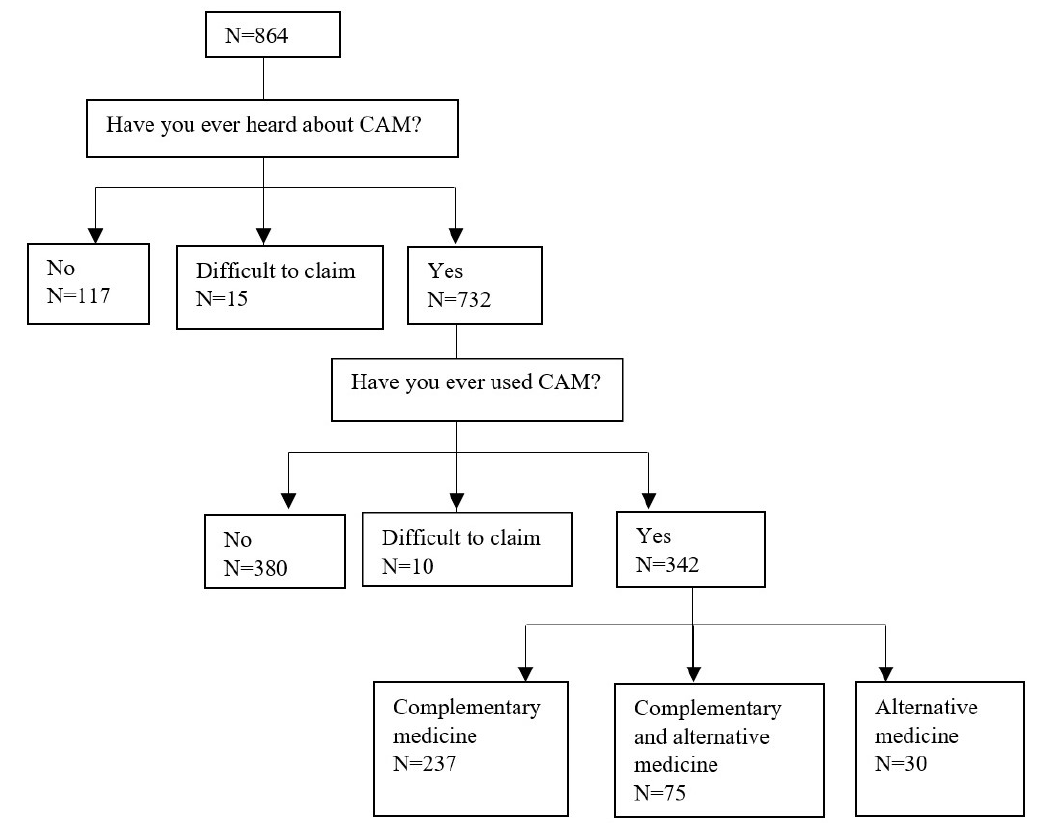
Figure 1. Flow diagram of patients included in the study.